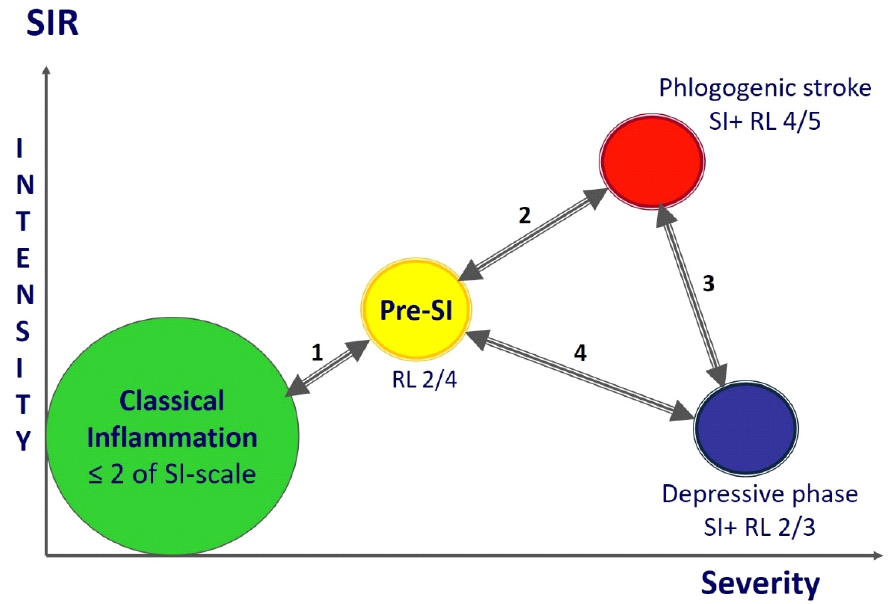
Figure 7. SI phases («punching» variant). Model scheme of the SI dynamics with variants of phases and interphase transitions during the gradual development of the process. Note. 1—Reversal from the pre-SI or SI development phase to the systemic manifestations of classical inflammation is the most favorable variant of the dynamics that is associated with SI relief and resolution (the SI development phase is not marked in the figure, but is in the same area as pre-SI); 2—in principle, the process of transition to hyperergic state is reversible in the early stages, but the process can be complicated by refractory shock and a complex of other life-threatening syndromes leading to lethal outcome; 3—the unfavorable dynamics variant regardless of the reversibility of hyper- and hypoergic critical SI phases, especially during the formation of the secondary phlogogenic stroke phase (5–8 days); 4—the transition to the pre-SI or resolution phase (reversible development) from the stable depressive phase of SI is unlikely, especially on in the longer term (>14 days) in the development of the critical condition.